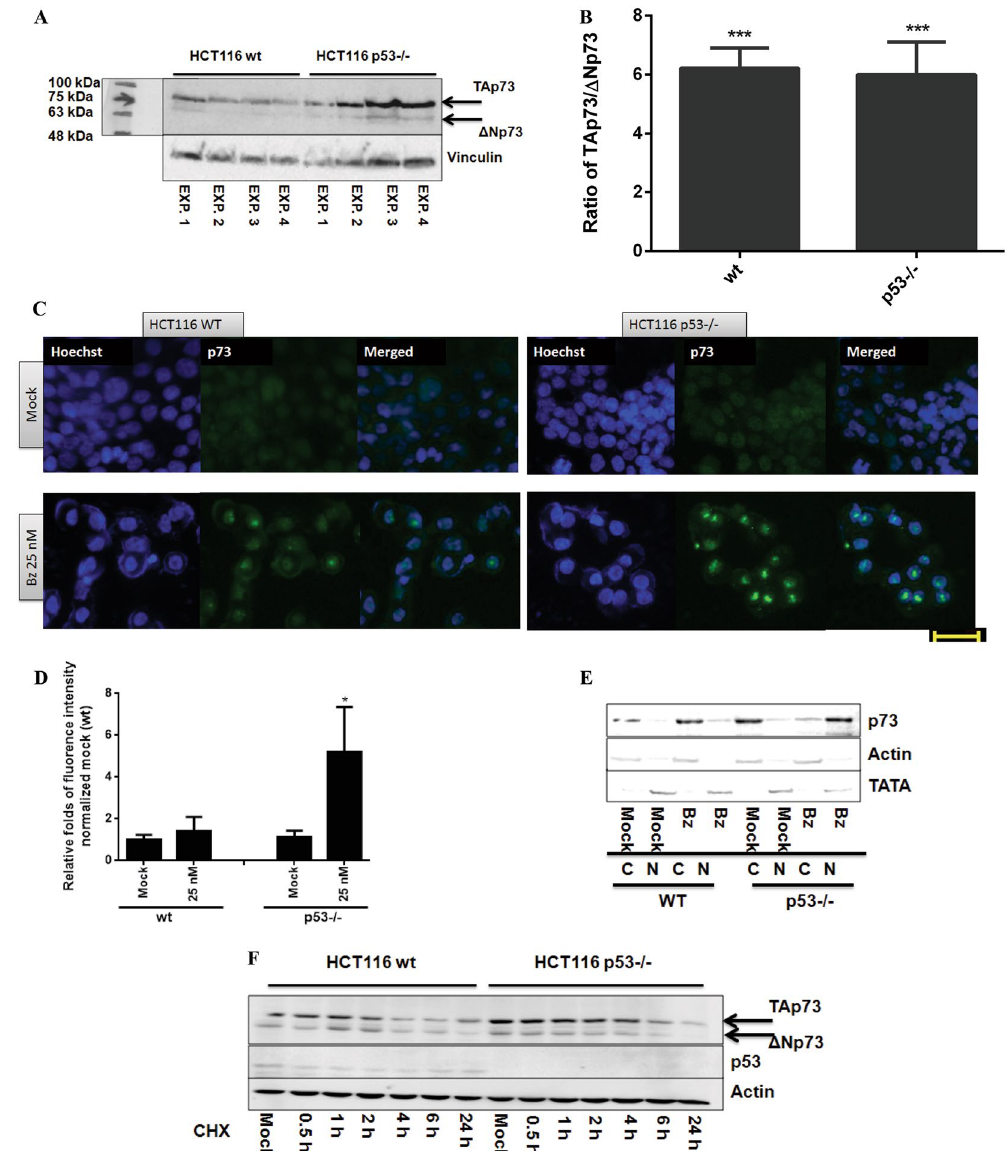
Figure 3. TAp73 represents as the majority of p73 protein expression in HCT116 wt and p53 − / − cells. ( A ) Two isoforms, TAp73 (85 kDa) and Δ Np73 (65 kDa), were reproducibly detected in HCT116 and p53 − / − cells. Vinvulin was used as loading control. ( B ) Densitometric analysis on the ratio of TAp73 and Δ Np73 expression. ( C ) Translocation of p73 to the nucleus upon treatment analyzed by immunocytochemistry. Scale bar: 40 µ m. DMSO (final concentration: 0.5%) was used as mock. ( D ) The quantification of fluorescence intensity, which is described in detail in the method section. ( E ) Nuclear accumulation of TAp73 occurred in the presence of bortezomib (50 nM) for 24 hrs detected by using separated nuclear and cytosolic fractions in wt and p53 − / − cells (C: cytosolic fraction, N: nuclear fraction). ( F ) p73 expression in the presence of cyclohexamide (CHX). HCT116 wt and p53 − / − cells were treated with 10 µ M CHX, collected at 0.5 h, 1 h, 2 h, 4 h, 6 h and 24 h and subjected to immunoblotting. ß-Actin was used as loading control. * P < 0.05 and *** p <